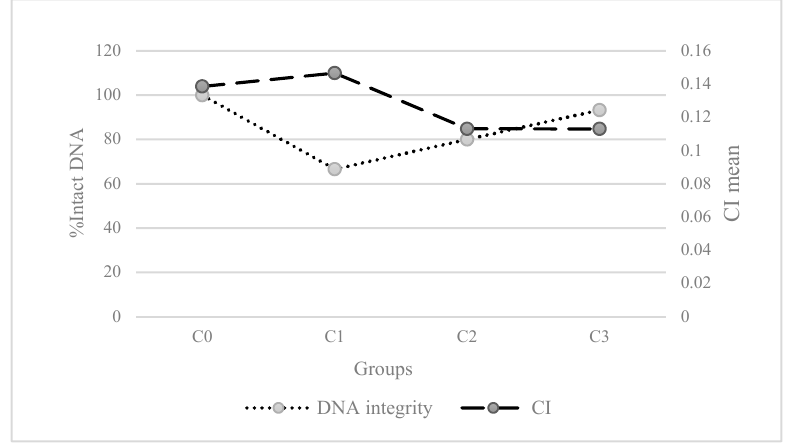
Figure 5. Diagram representing the trends of the different groups for condition index (CI), and the proportion of individuals with integer DNA (score = 1 for DNA integrity).